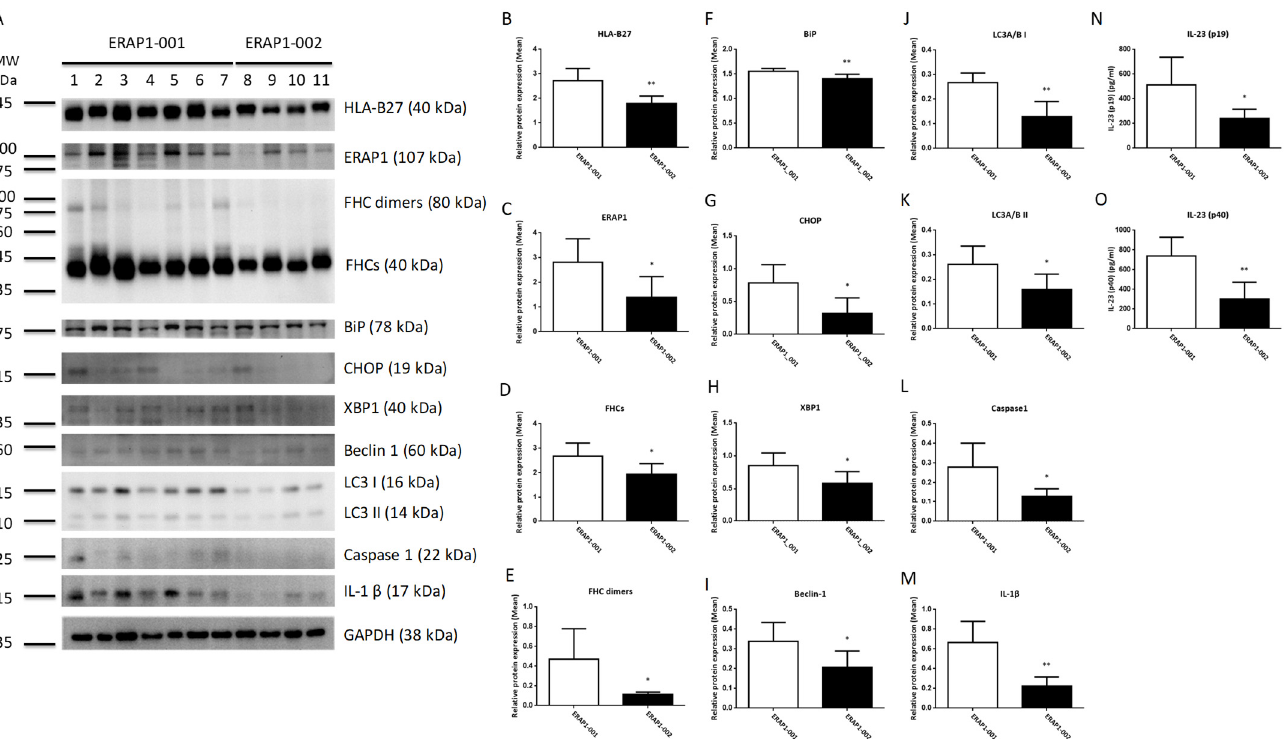
Figure 1. PBMCs from ERAP1-001 and ERAP1-002 homozygous human subjects produced significantly different levels of ERAP1 and related proteins. Proteins in cell lysates of PBMCs were detected by Western blot analysis and a panel of proteins from seven ERAP1-001 and four ERAP1-002 homozygous donors were analyzed ( A ). Band intensities were quantified from the digital image by densitometry using Image and were normalized to the loading control. PBMCs of ERAP1-001 homozygous donors produced significantly higher levels of HLA-B27 ( B ), ERAP1 ( C ), MHC class I free heavy chain or FHCs ( D ), FHC dimers ( E ), immunoglobulin heavy-chain binding protein (BiP) ( F ), CCAAT-enhancer-binding protein homologous protein (CHOP) ( G ), X-box-binding protein 1 (XBP1) ( H ), Beclin-1 ( I ), LC3 I ( J ), LC3 II) ( K ), Caspase 1 ( L ), and IL-1 β ( M ) as compared to ERAP1-002 homozygous donors. ELISA was used to detect IL-23 (p19/p40) in culture media. PBMCs from ERAP1-001 homozygous donors produced significantly higher level of IL-23 p19 (512.1 ± 84.94 versus 241.9 ± 36.40, p = 0.0478) ( N ) and p40 (740.4 ± 71.25 versus 301.7 ± 85.72, p = 0.0041) ( O ) than PBMCs of ERAP1-002 homozygous donors (data are shown as means with SD). Data are representative of three experiments. * p < 0.05, ** p < 0.01.